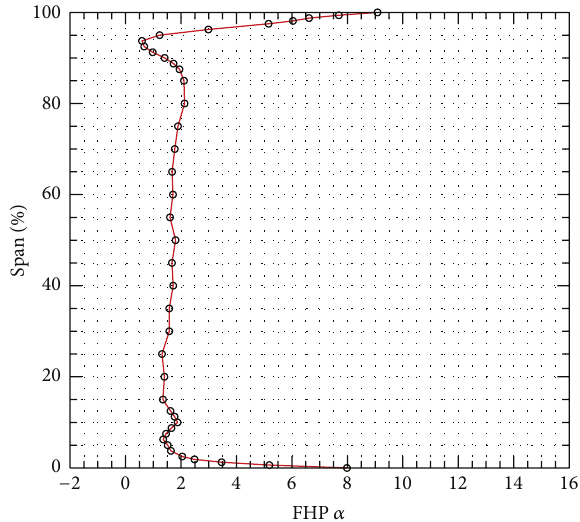
Figure 21: Mass averaged FHP measured pitch ( 𝛼 ) angle, intraspace.